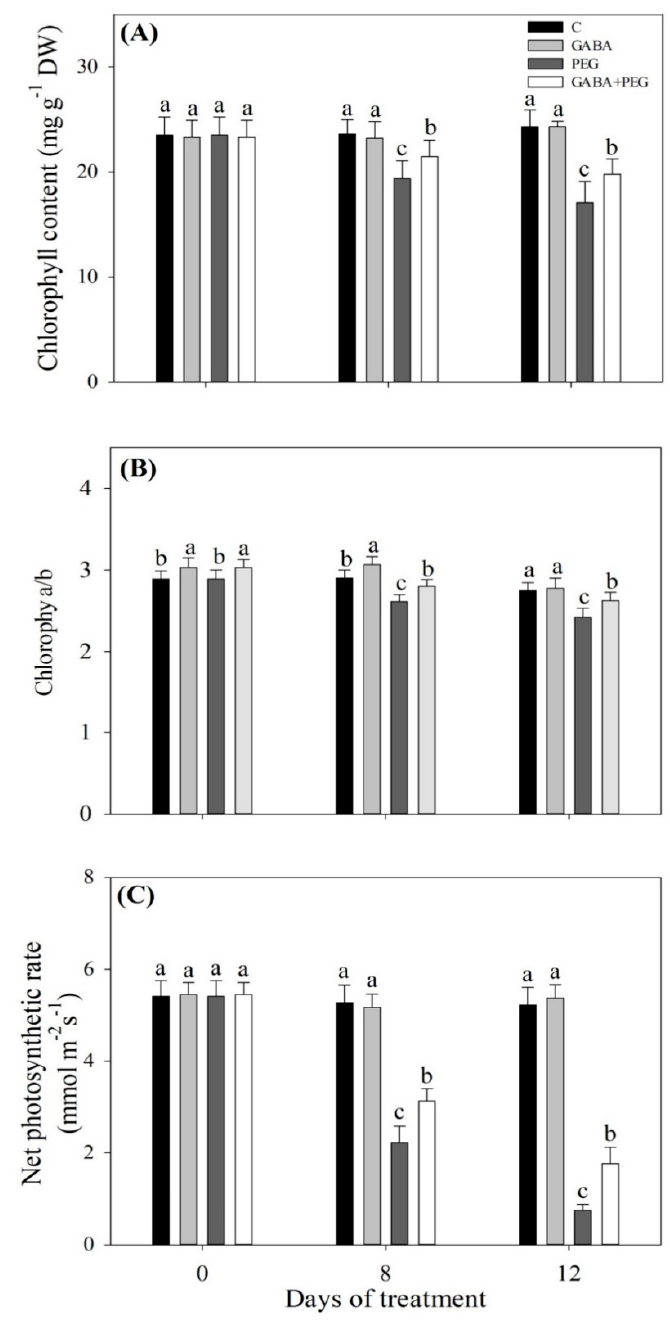
Figure 2. Effects of γ -aminobutyric acid (GABA) pretreatment on ( A ) total chlorophyll content, ( B ) chlorophyll a/b, and ( C ) net photosynthetic rate in leaves of creeping bentgrass under non-stress and water stress conditions. Vertical bars indicate ± SE of mean ( n = 4). Different letters above columns indicate significant difference at a particular day based on the LSD ( P ≤ 0.05). C, well-watered control; GABA, well-watered control pretreated with GABA; PEG, PEG-induced water stress; GABA + PEG, water-stressed plants pretreated with GABA.